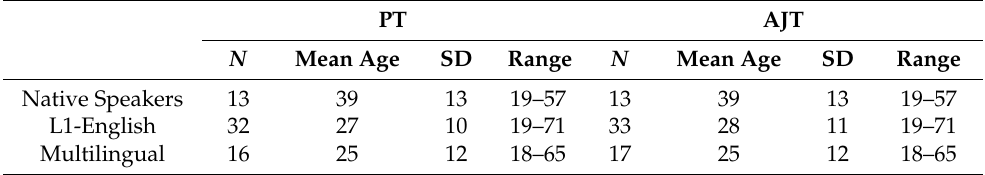
Table 1. L1 and L2 Participants in the Preference Task (PT) and Acceptability Judgement Task (AJT). PT AJT N Mean Age SD Range N Mean Age SD Range Native Speakers